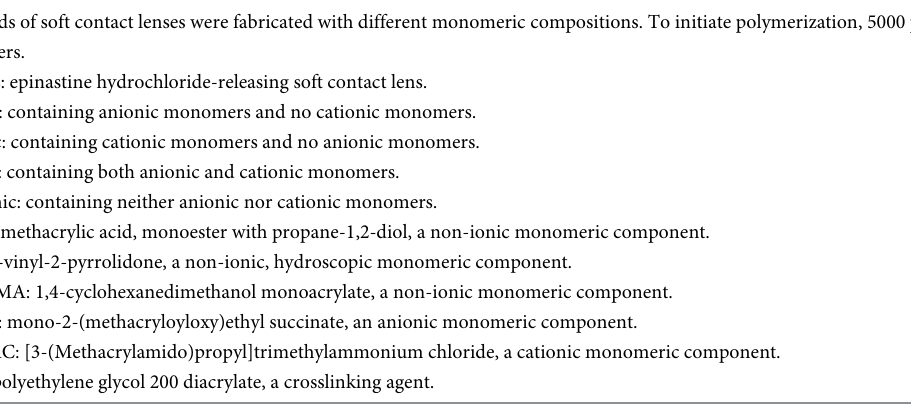
Five kinds of soft contact lenses were fabricated with different monomeric compositions. To initiate polymerization, 5000 ppm of AIBN was added to each mixture of monomers.